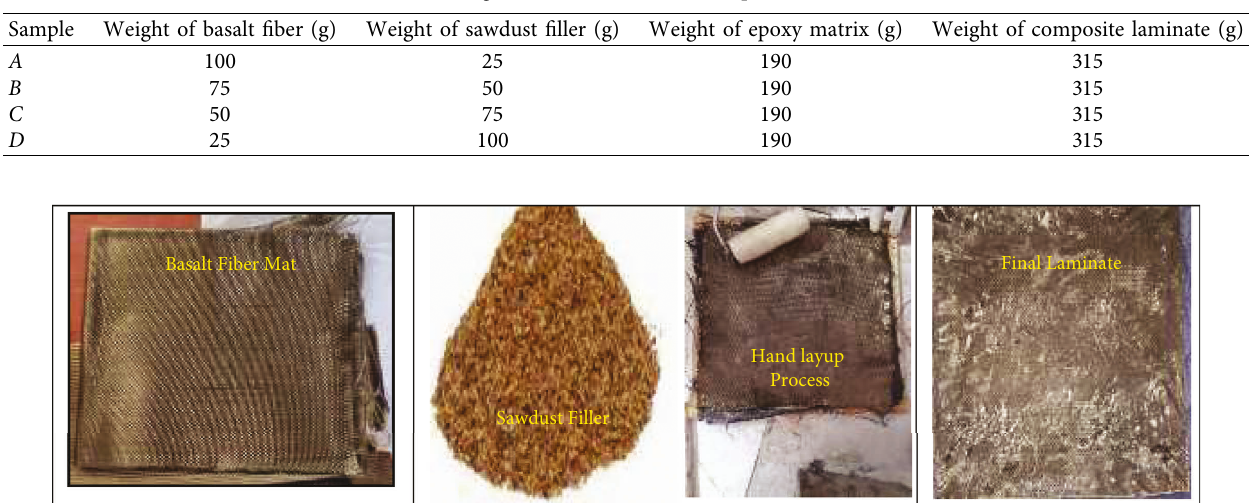
Table 2: Weight ratio of basalt fiber composite laminates.